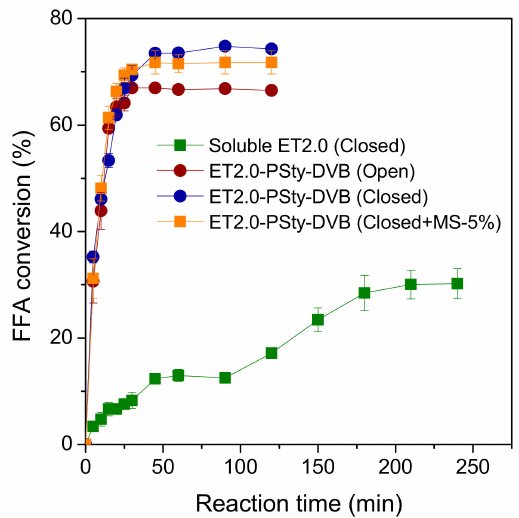
Figure 2. Influence of reaction time on the MAE production in solvent-free systems catalyzed by solu- ble or immobilized ET2.0 on PSty-DBV beads using different water removal strategies. The reactions were at 40 ◦ C, 240 rpm, stoichiometric FFA:fusel oil molar ratio (1:1), and protein concentration of 5 mg · g − 1 of reaction mixture. Table 1. Estimation of productivity for the enzymatic production of monoalkyl esters catalyzed with soluble or immobilized ET2.0 on PSty-DBV beads using different water removal strategies. Reaction